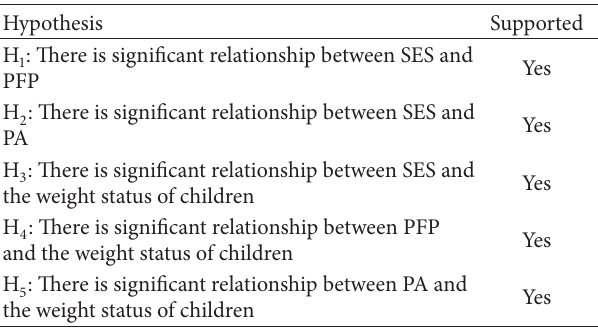
Table 13: Results of the testing of the hypotheses.